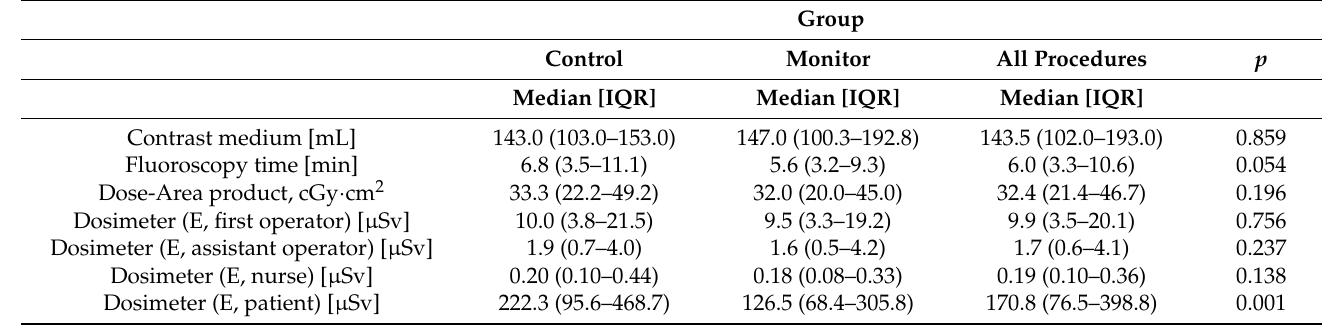
Table 5. Exposure in interventional